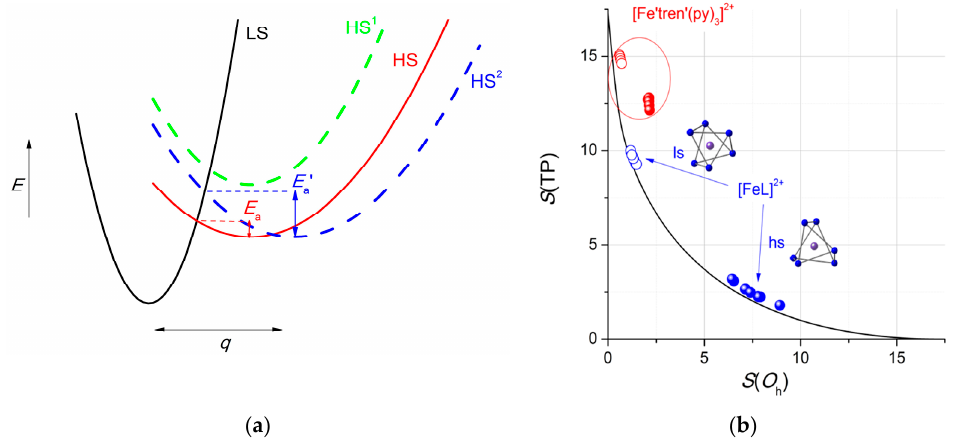
Figure 7. ( a ) Parabolic representation of the potential surface of an SCO complex; effects of vertical (green; variation of Δ SCO E ) and horizontal displacements (blue; variation of q ) are highlighted; arrows denote the activation barriers.; ( b ) shape map of the O h –TP structure transition in [FeL] 2+ (blue) and [Zn(tren)py 3 ] 2+ (red); line: ideal Bailar-type trigonal twist.